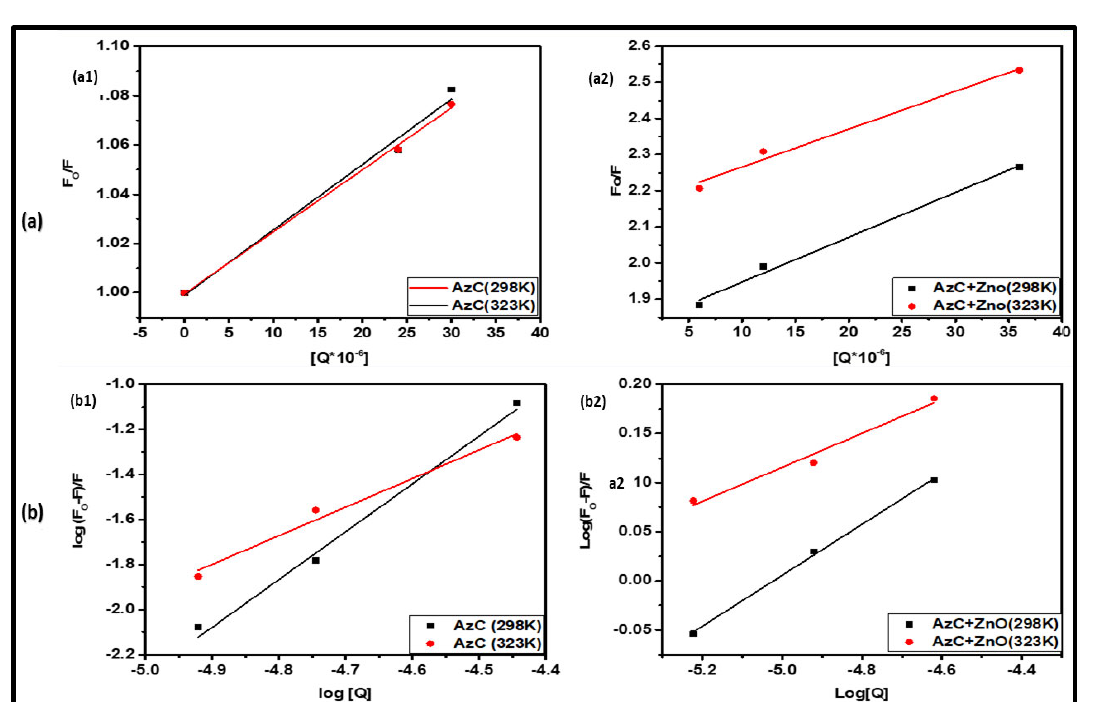
Figure 5. ( a ) Stern ‐ Volmer plot of Chymo ‐ AzC ( a1 ) and AzC ‐ ZnONPs ( a2 ) at two different temperatures 293 K and 323 K. ( b ) Double logarithm plot for fluorescence quenching of Chymo ‐ AzC ( b1 ) and AzC ‐ ZnONPs ( b2 ) at temperatures 293 K and 323 K.